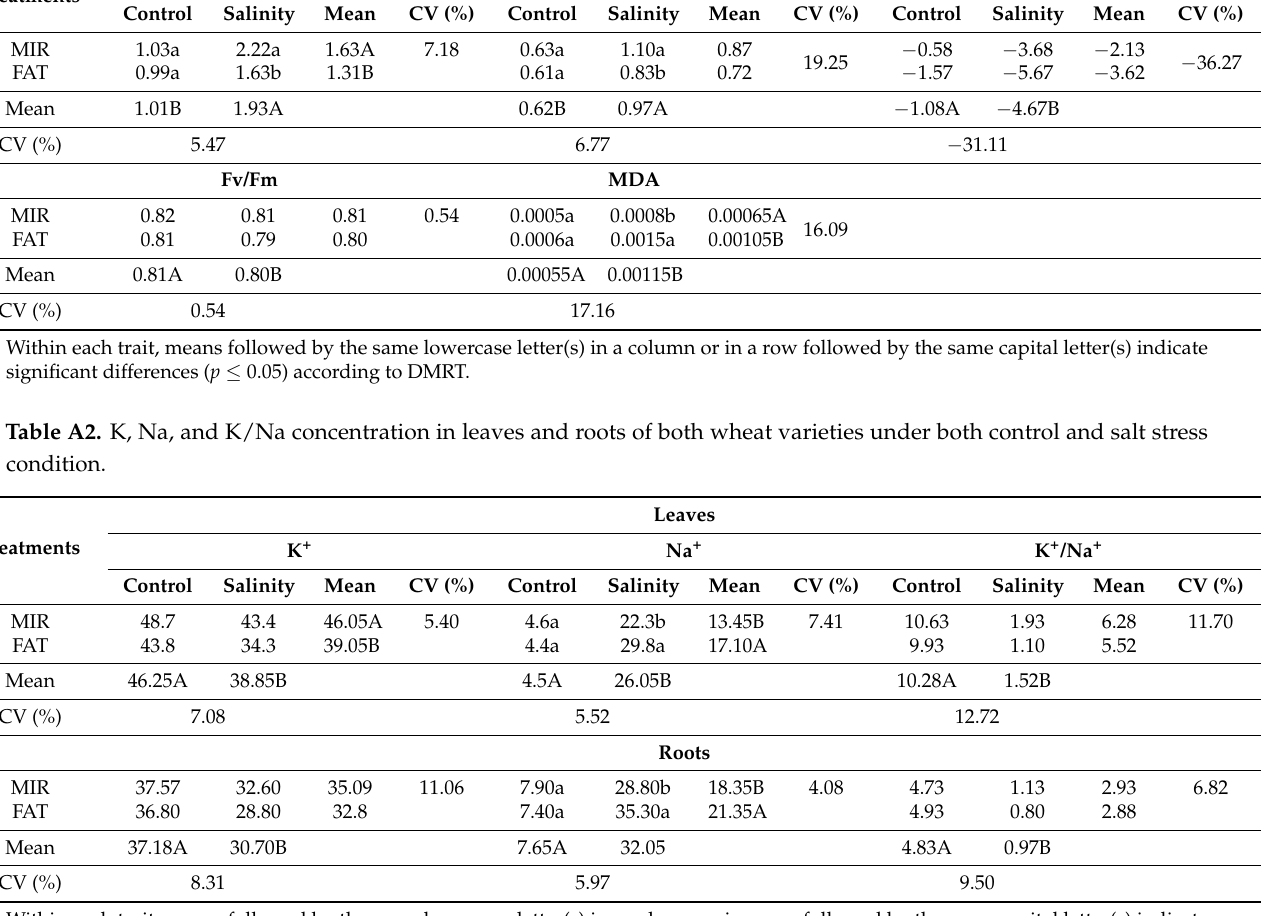
Table A1. APX: CAT, osmotic potential, Fv/Fm, and MDA of wheat varieties under both control and salt stress condition. Treatments